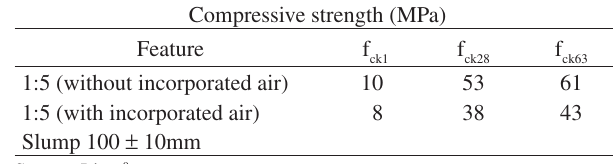
Table 4. Compressive strength for the concrete exposed to a temperature of –35 °C.